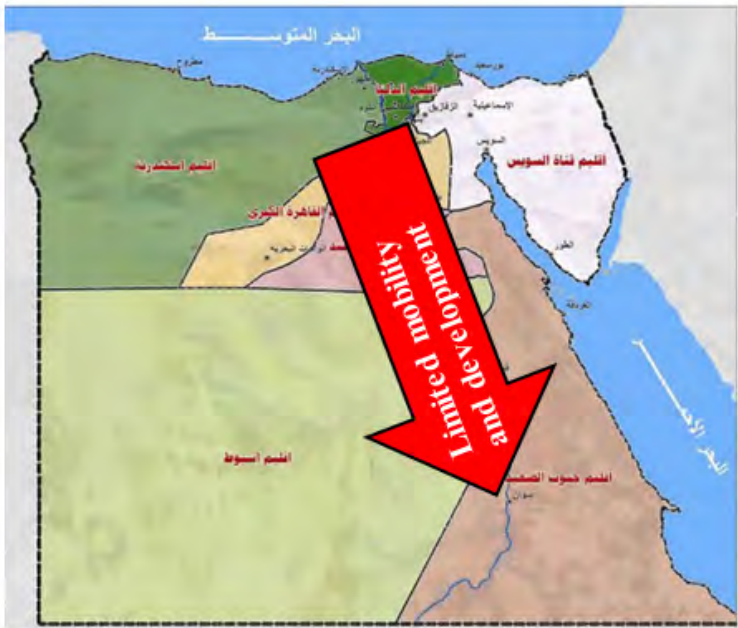
Figure 6. A map showing the limited development movement on the banks of the Nile Source: Sustainable Development Strategy 2030 - Ministry of Planning, Follow - up and Administrative Reform